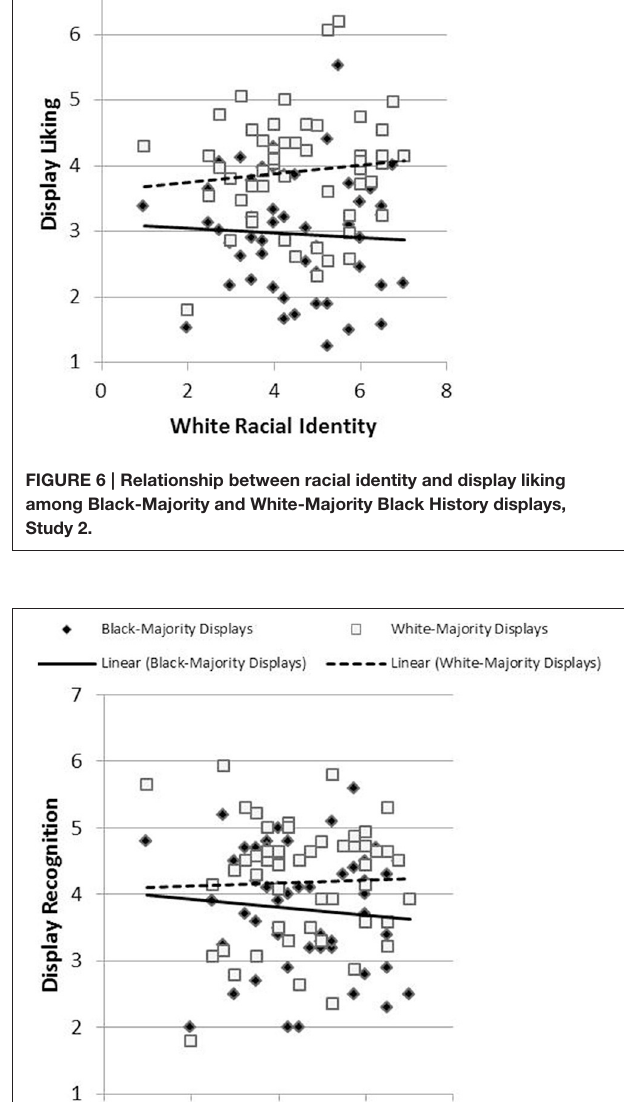
between display ratings and White American identification. The relationship between White American identification and responses to Black History representations was significantly more negative in reaction to displays from Black-Majority schools than White-Majority